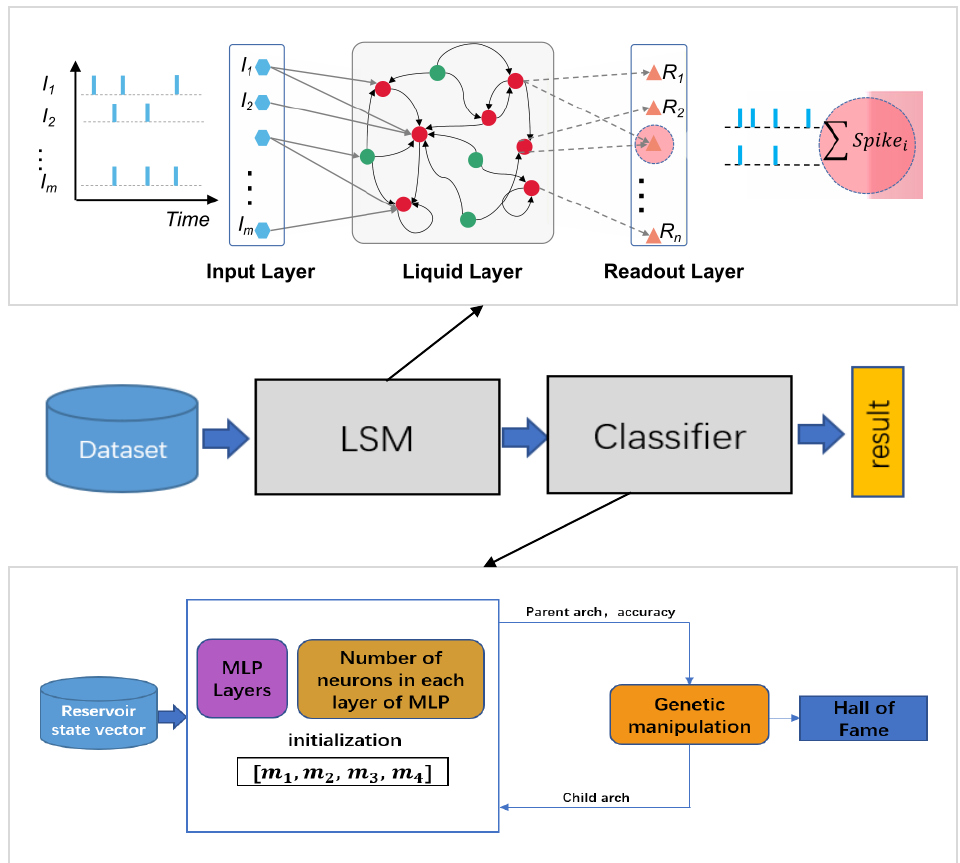
Figure 2. Workflow of proposed